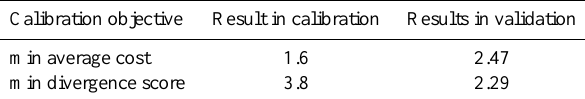
Table 2. The resulting average disutility per year, composed of costs for action and losses for unpredicted events, is minimized by explicitly calibrating on it, but performance in the validation period is better for the probabilistic model trained to minimize remaining